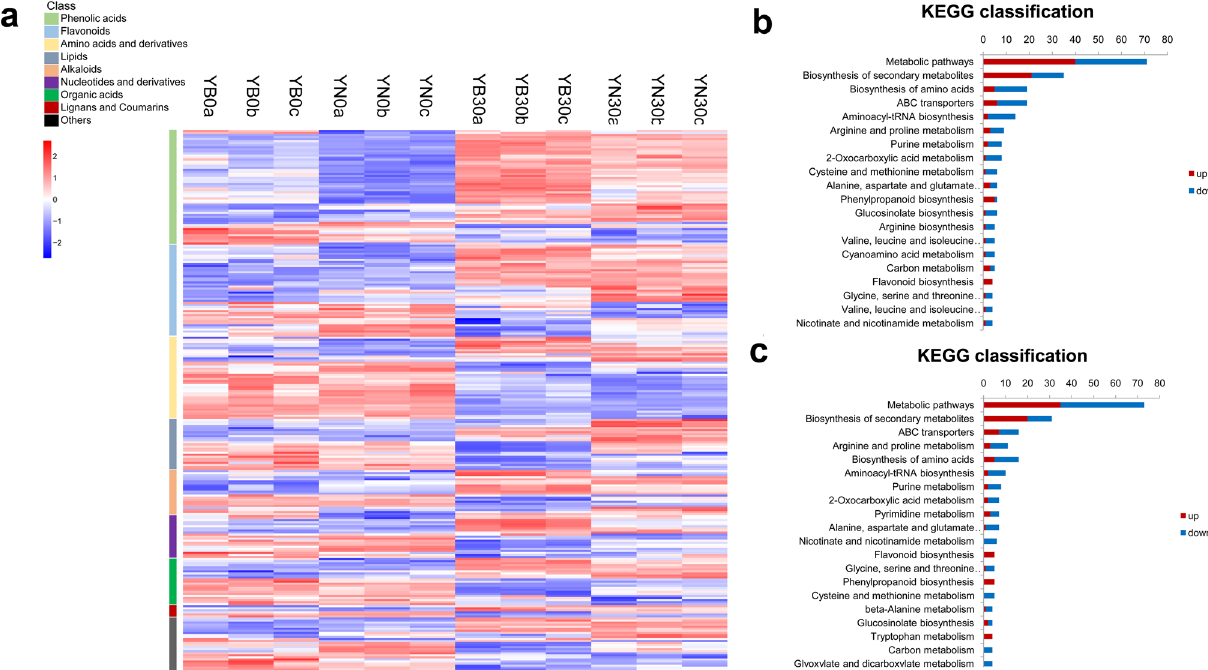
Figure 3. Analysis of differentially accumulated metabolites. ( a ) Heat map analysis of differentially accumulated metabolites. The data are homogenized by row. ( b ) KEGG classification of differentially accumulated metabolites in the YN0 versus YN30 comparison. The abscissa represents the number of metabolites. ( c ) KEGG classification of differentially accumulated metabolites in the YB0 versus YB30 comparison. The abscissa represents the number of